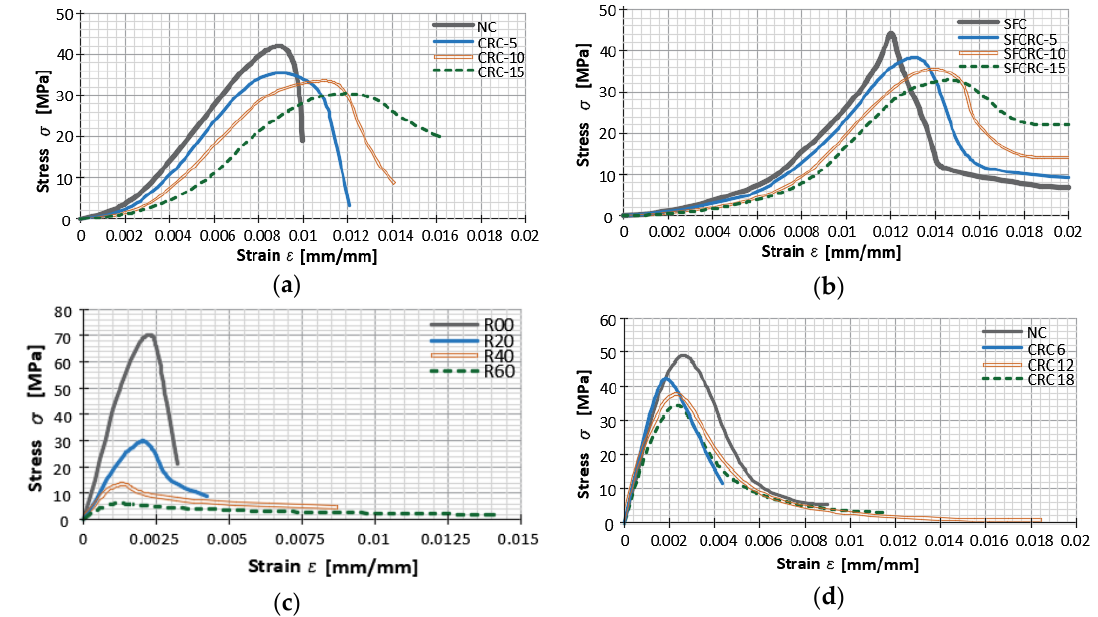
Figure 1. Stress-strain curves of: ( a ) normal concrete (NC), rubberized concrete with 5% rubber (CRC-5), 10% rubber (CRC-10), 15% rubber (CRC-15) [25]; ( b ) steel fiber concrete (SFC), steel fiber rubberized concrete with 5% rubber (SFCRC-5), 10% rubber (SFCRC-10), 15% rubber (SFCRC-15%) [25]; ( c ) traditional concrete (R00), rubberized concrete with 20% rubber (R20), 40% rubber (R40), and 60% rubber (R60) [3]; ( d ) NC, concrete with 6% crumb rubber (CRC6), 12% (CRC12), 18% (CRC18) [23].